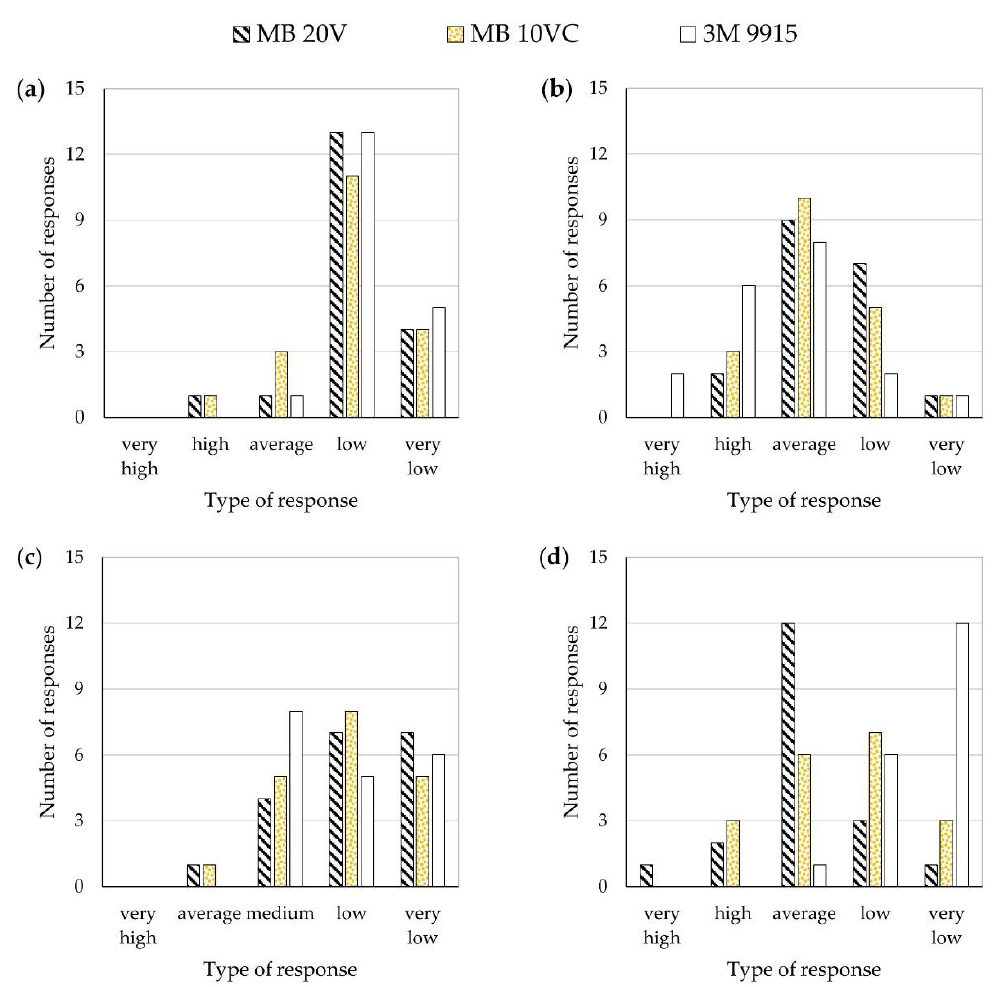
Figure 5. Questionnaire results: ( a ) leak-tightness, ( b ) comfort, ( c ) donning and fitting difficulty level, and ( d ) perception of odor reduction.